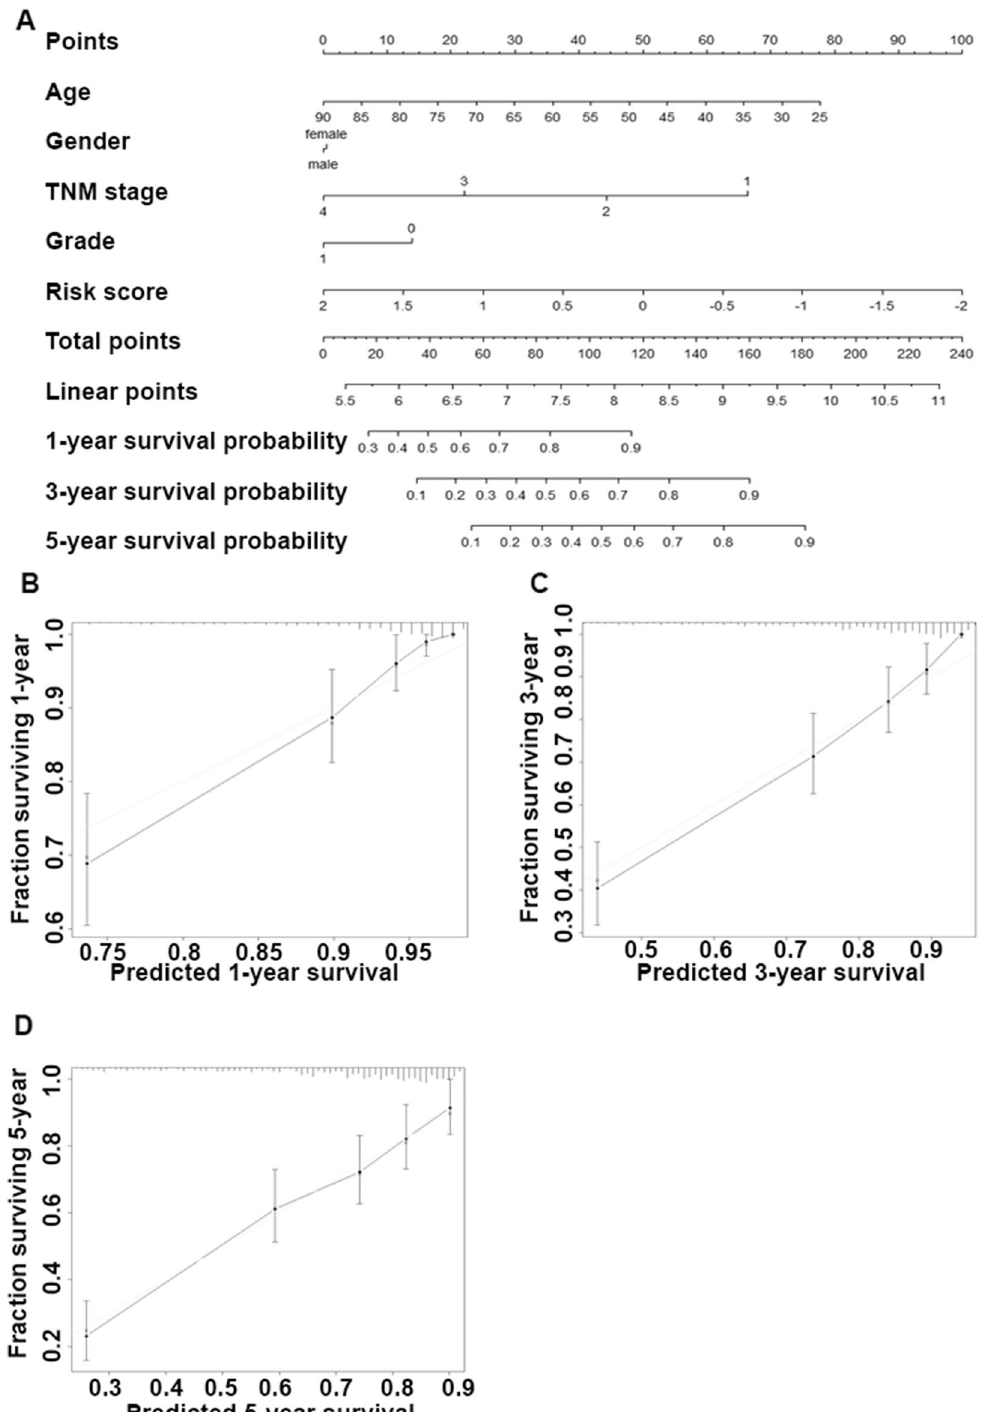
Figure 6. Nomogram Construction and Validation. ( A ) The nomogram for quantitatively predicting 1-, 3-, and 5-year overall survival of patients in TCGA-KIRC cohort (n = 531); ( B – D ) Calibration curve of the 1-, 3-, and 5-year overall